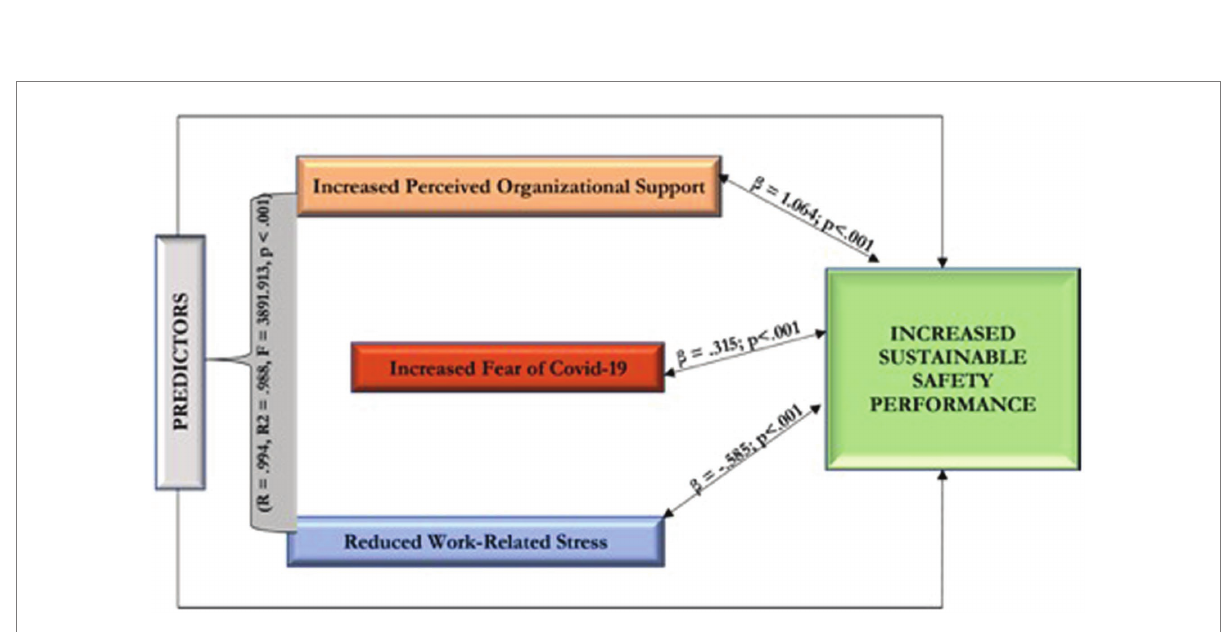
FIGURE 2 A practical model to inspire and sustain SP during the COVID-19